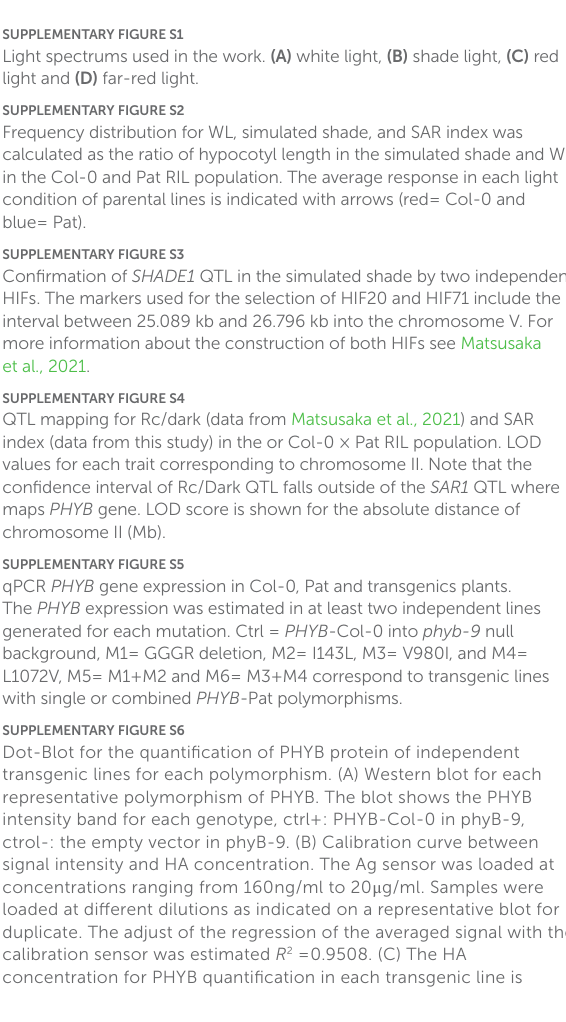
SUPPLEMENTARY FIGURE S1 Light spectrums used in the work. (A) white light, (B) shade light, (C) red light and (D) far-red light. SUPPLEMENTARY FIGURE S2 Frequency distribution for WL, simulated shade, and SAR index was calculated as the ratio of hypocotyl length in the simulated shade and WL in the Col-0 and Pat RIL population. The average response in each light condition of parental lines is indicated with arrows (red= Col-0 and blue= Pat). SUPPLEMENTARY FIGURE S3 Confirmation of SHADE1 QTL in the simulated shade by two independent HIFs. The markers used for the selection of HIF20 and HIF71 include the interval between 25.089 kb and 26.796 kb into the chromosome V. For more information about the construction of both HIFs see Matsusaka et al., 2021. SUPPLEMENTARY FIGURE S4 QTL mapping for Rc/dark (data from Matsusaka et al., 2021) and SAR index (data from this study) in the or Col-0 × Pat RIL population. LOD values for each trait corresponding to chromosome II. Note that the confidence interval of Rc/Dark QTL falls outside of the SAR1 QTL where maps PHYB gene. LOD score is shown for the absolute distance of chromosome II (Mb). SUPPLEMENTARY FIGURE S5 qPCR PHYB gene expression in Col-0, Pat and transgenics plants. The PHYB expression was estimated in at least two independent lines generated for each mutation. Ctrl = PHYB -Col-0 into phyb-9 null background, M1= GGGR deletion, M2= I143L, M3= V980I, and M4= L1072V, M5= M1+M2 and M6= M3+M4 correspond to transgenic lines with single or combined PHYB -Pat polymorphisms. SUPPLEMENTARY FIGURE S6 Dot-Blot for the quantification of PHYB protein of independent transgenic lines for each polymorphism. (A) Western blot for each representative polymorphism of PHYB. The blot shows the PHYB intensity band for each genotype, ctrl+: PHYB-Col-0 in phyB-9, ctrol-: the empty vector in phyB-9. (B) Calibration curve between signal intensity and HA concentration. The Ag sensor was loaded at concentrations ranging from 160 ng/ml to 20 μ g/ml. Samples were loaded at different dilutions as indicated on a representative blot for duplicate. The adjust of the regression of the averaged signal with the calibration sensor was estimated R 2 = 0.9508. (C) The HA concentration for PHYB quantification in each transgenic line